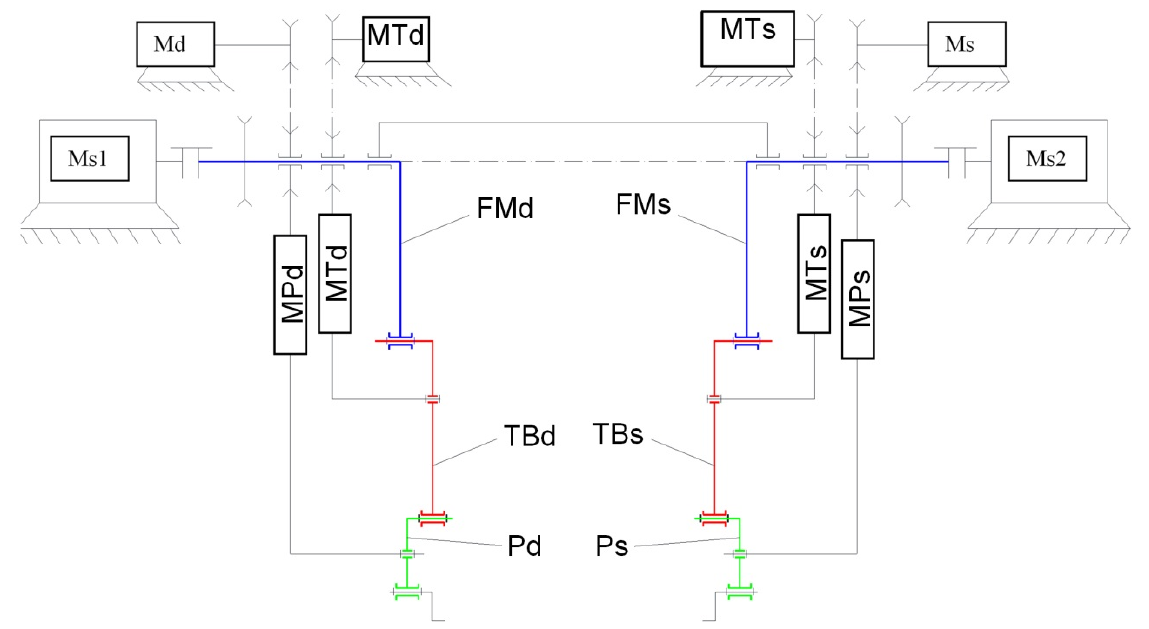
Figure 6. Exoskeleton functional principle design.